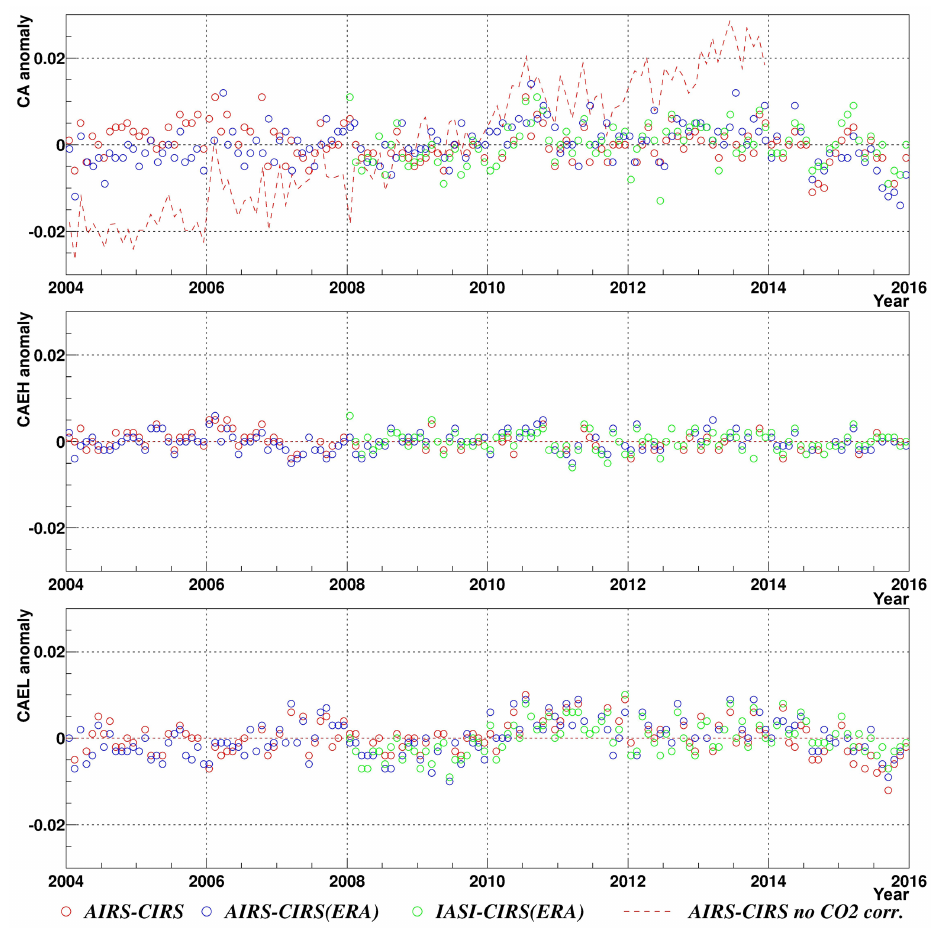
Figure 10. Time anomalies of deseasonalized CA, CAEH and CAEL over the globe. In the case of CA, additional values are shown without calibration of spectral atmospheric transmissivities for changes in atmospheric CO 2